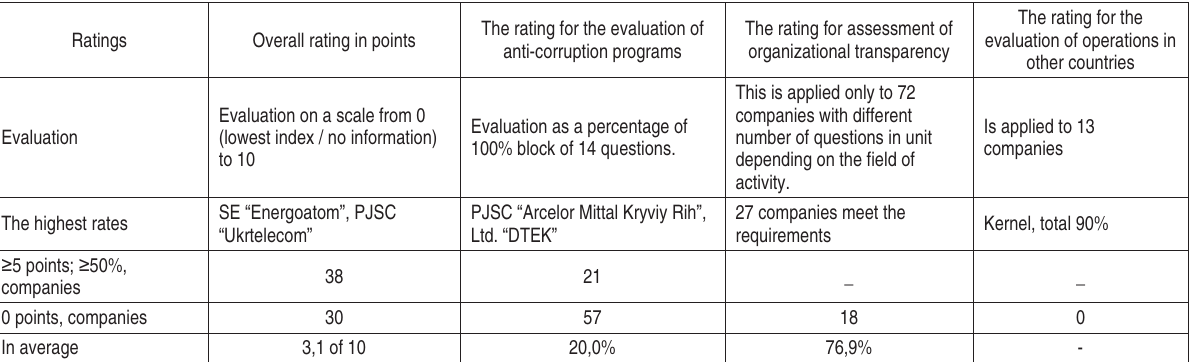
Table 3. Assessment of transparency of public companies in Ukraine by the method of Transparency International Ukraine, TI Ukraine